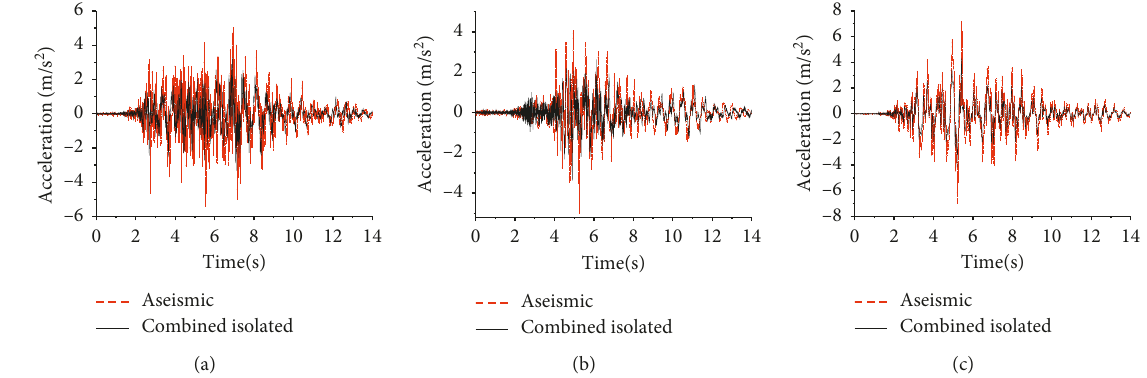
Figure 7: X -axis acceleration time history curves of the third floor of the main frame. (a) Chi-Chi-2N, (b) Chi-Chi-2F, and (c) Chi-Chi-3N.